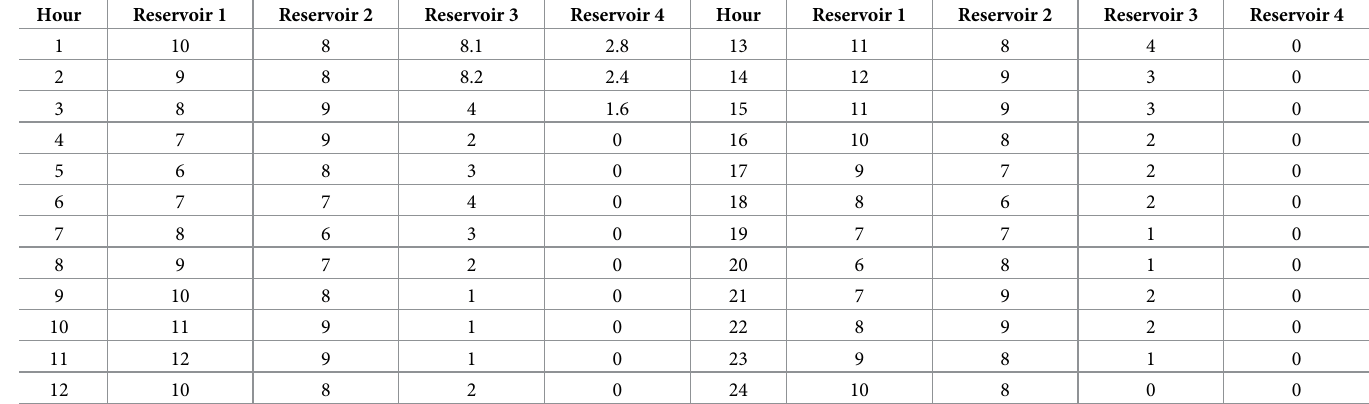
Table 5. Reservoir inflows.